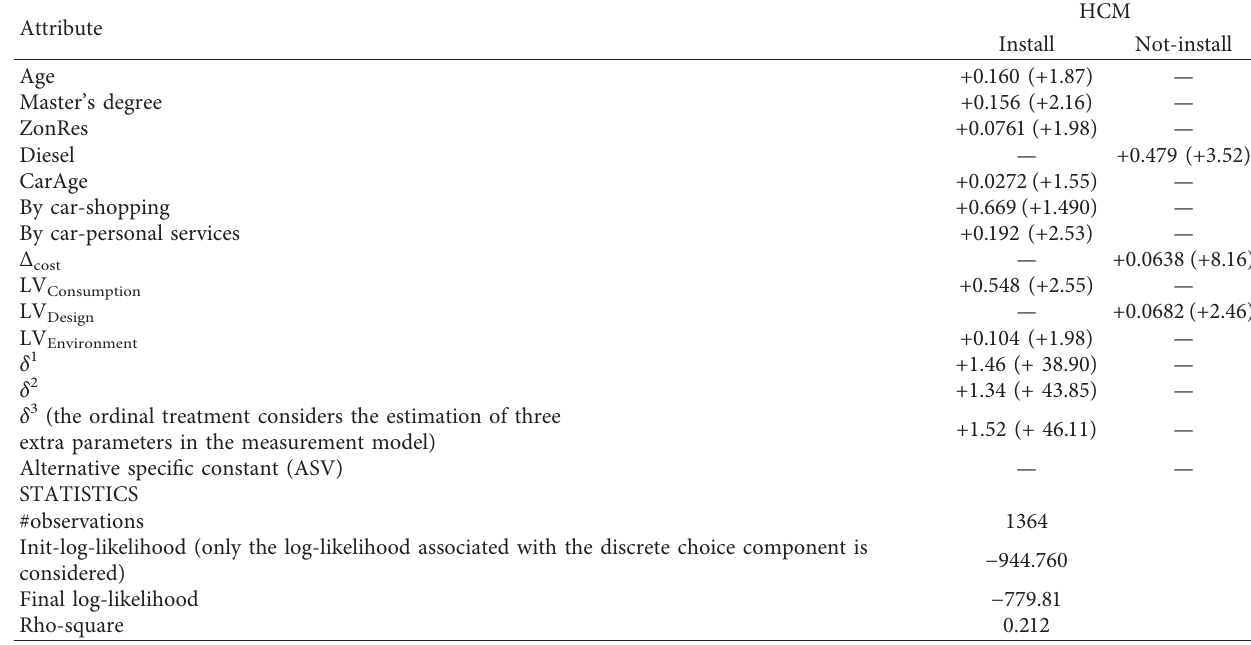
Table 7: Estimation results of